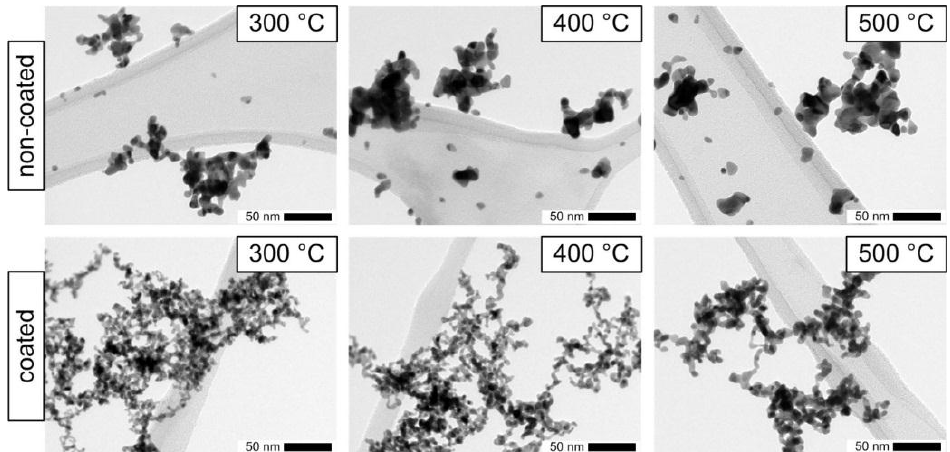
Figure 13. TEM micrographs showing the sintering behavior of non-coated ( top ) and coated ( bottom ) Pt particles during the transit through a tube furnace (residence time at 24 °C of 8 s).